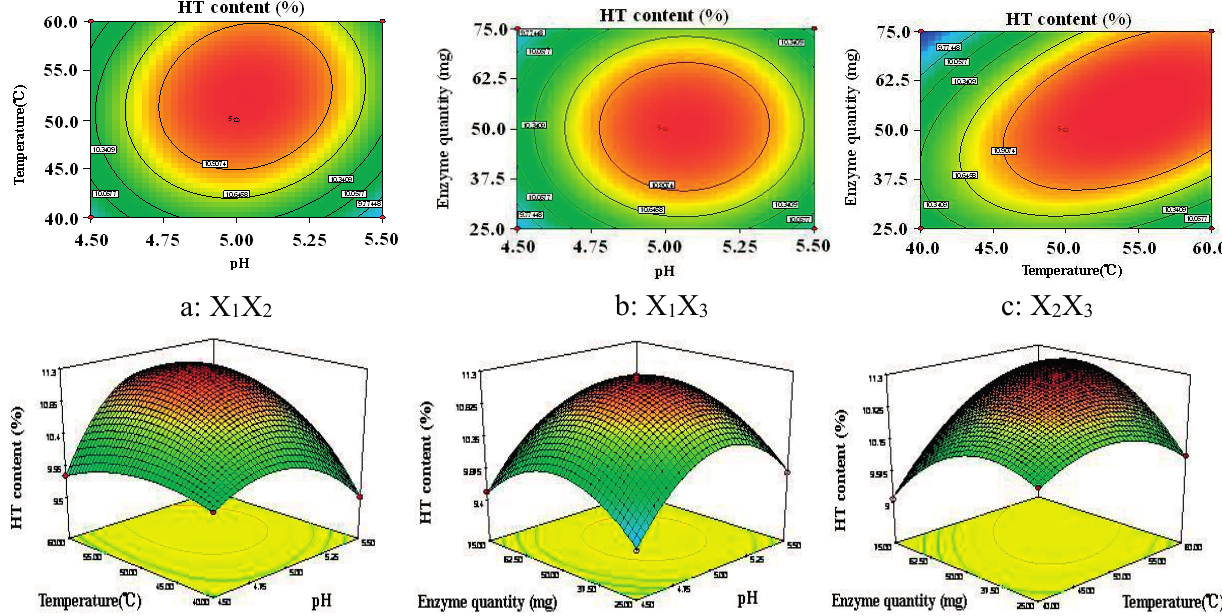
Figure 5. Contour plots and 3D-response surface plots showing the interactive effects of pH and temperature ( a , X 1 X 2 ), pH and enzyme quantity ( b , X 1 X 3 ), temperature and enzyme quantity ( c , X 2 X 3 ). (X 1 , pH; X 2 , temperature; X 3 , enzyme